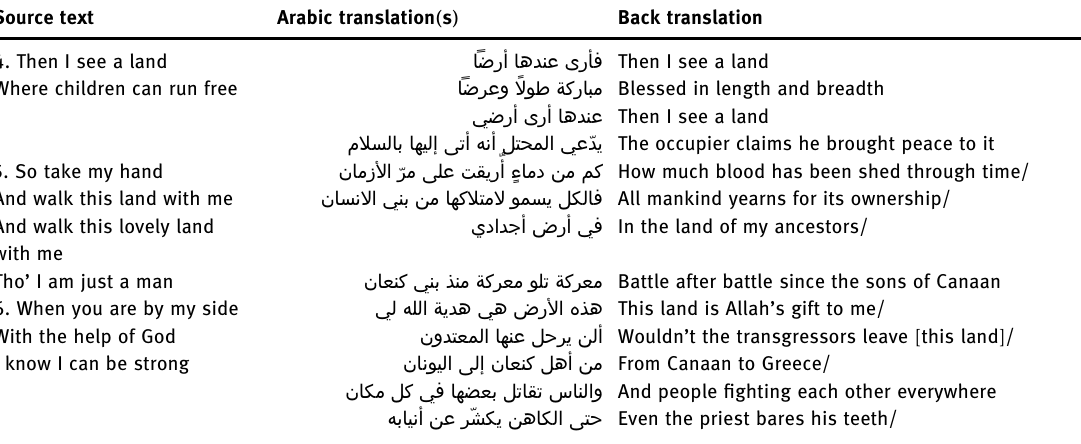
Table 2: Examples of resistant translations in relation to verbal – visual signs Source